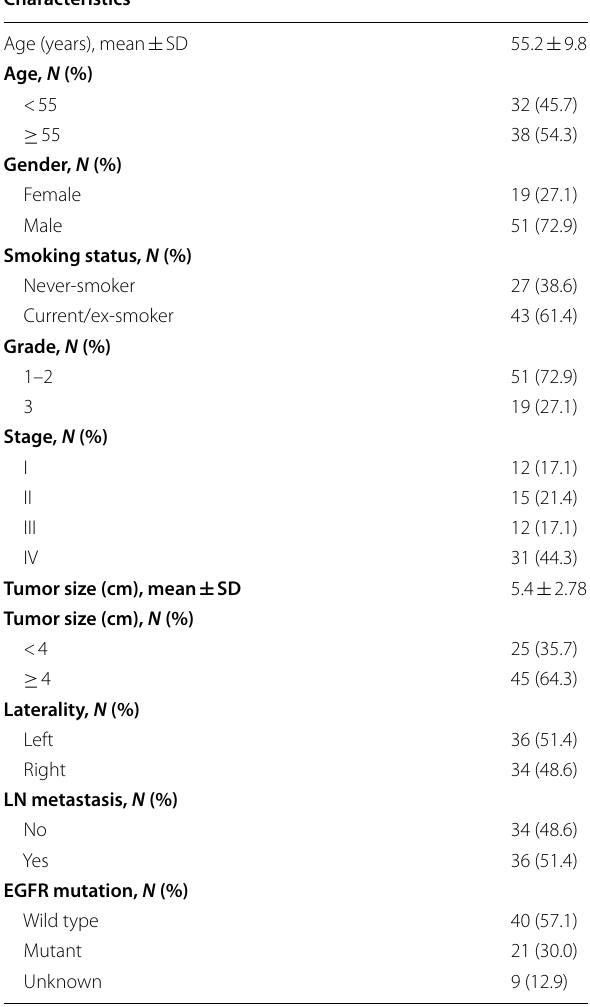
LN lymph node, EGFR epidermal growth factor receptor